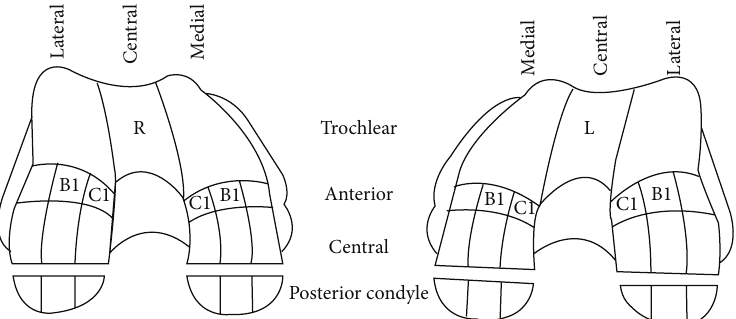
Figure4:ICRSalphanumericalmappingofcartilagelesions.B1andC1regionoftheanteromedialfemoralcondyleofbothkneesareindicated in the images. (Adapted from ICRS Cartilage Injury Evaluation Package.)